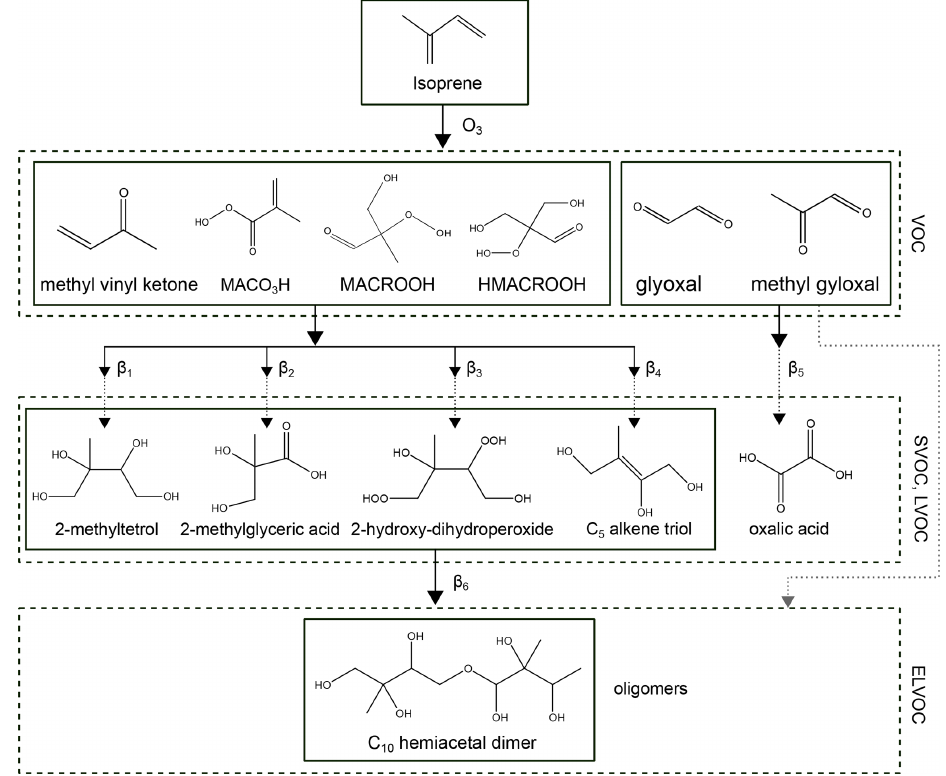
Figure 1. The system of selected isoprene-derived SOA surrogate components for use with the gas–particle partitioning model. This rela- tively simple system consists of early generation gas-phase oxidation products, with yields that were directly predicted by MCM, shown in the figure as VOC compounds, and a set of selected higher-generation oxidation products in the form of SVOC and LVOC surrogate species, including an oligomer species (an ELVOC at 283.15K). β 1 – β 6 represent scaling parameters used to calculate the pseudo-molar yields of the higher-generation oxidation products from the concentrations of MCM-predicted early-generation